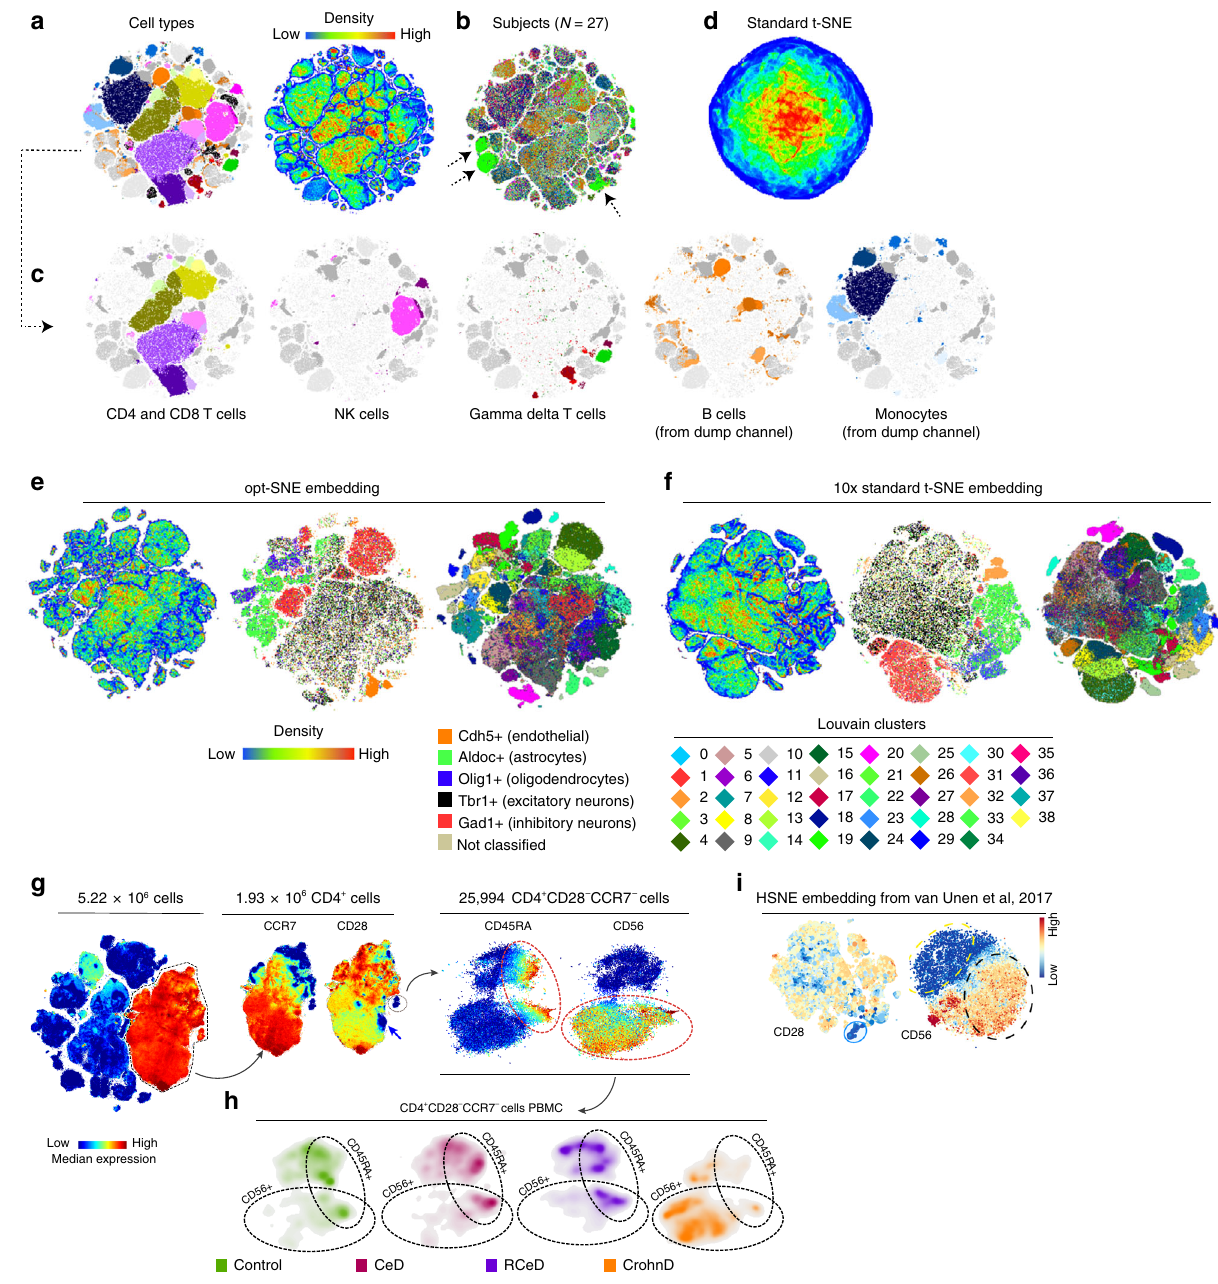
Fig. 6 opt-SNE allows high-quality visualization of large cytometry and transcriptomics datasets. a – d 20 million datapoints from fl uorescent cytometry dataset concatenated from 27 subjects vizualized in 2D space. a , c Cell type classes and density overlaid on 2D opt-SNE embedding. b Subject identi fi er overlaid on 2D opt-SNE embedding. Dashed arrows indicate clusters represented by datapoints from a single subject. d Standard t-SNE visualization (4000 iterations). e , f 10x Genomics mouse brain scRNA-seq dataset (1.3 million datapoints) visualized in 2D space with opt-SNE ( e ) or standard t-SNE ( f ). From left to right: density features, single gene classes, and Louvain clusters (0 – 38) overlays. g 5.22 million datapoints from mass cytometry dataset used in van Unen et al (2017) visualized in 2D space with opt-SNE. From left to right: CD4 expression overlaid on opt-SNE embedding; CCR7 and CD28 expression overlaid on CD4 + opt-SNE cluster; CD45RA and CD56 expression intensity overlaid on CD4 + CD28 − CCR7 − cluster. h CD4 + CD28 − CCR7 − cells from control, celiac disease (CeD), refractory celiac disease (RCeD) and Crohn ’ s disease (CrohnD) subjects presented on density plots. Dashed encirclements indicate CD45RA + and CD56 + areas of the cluster as de fi ned in g . i Hierarchical t-SNE (HSNE) embedding of the CD4 (left) and CD4 + CD28 − cluster (right) reproduced from van Unen et al. 7 (licensed under a Creative Commons Attribution 4.0; http://creativecommons.org/licenses/by/4.0/). Color indicates marker expression